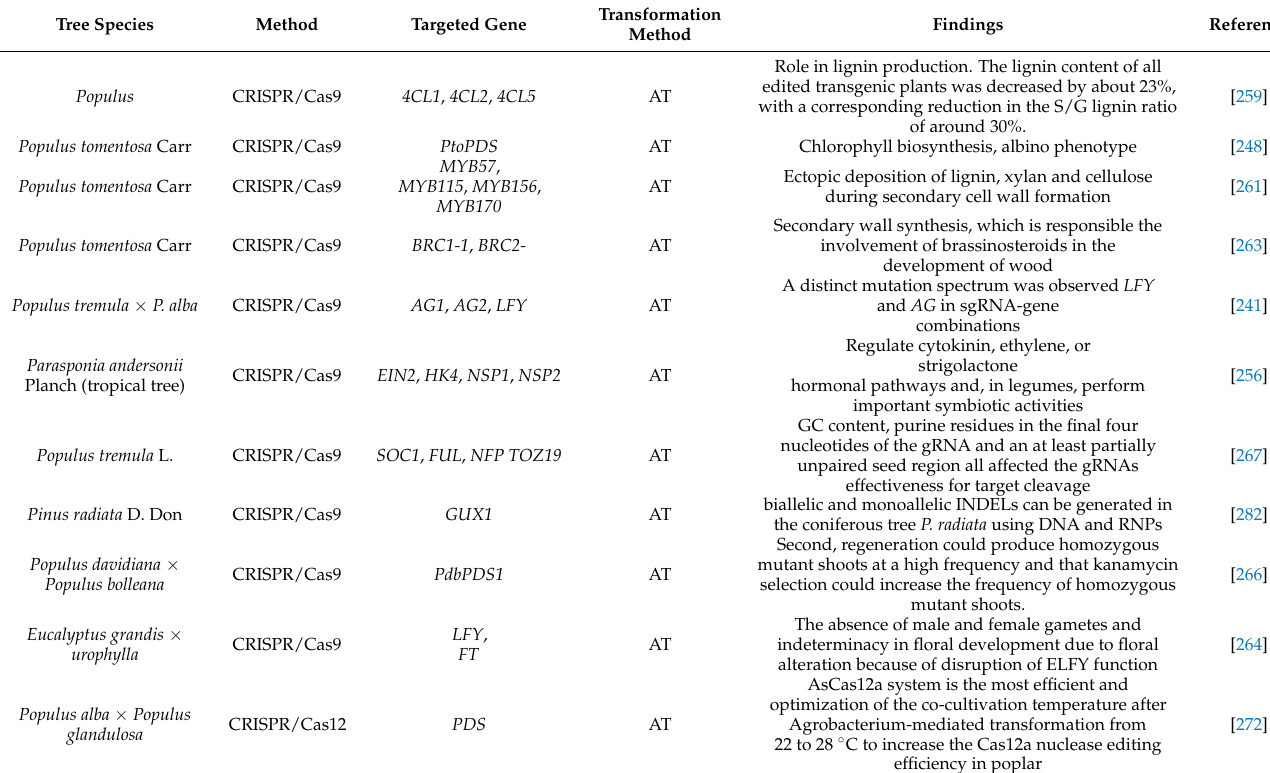
Figure 2. Construction of CRISPR/Cas9 vector with GRF-GIF chimeras to edit the genomes of tree breeding populations. After constructing the vector, do the transformation as per available protocol in the lab with different genotypes. The regenerated plant should be grown under speed breeding protocol to boost the growth period for the phenotypic and genotypic analysis to do further investigation quickly modified by [275]. Table 3. List of tree species successfully transformed genetically and potential candidates to be genome-edited with CRISPR/Cas9 and